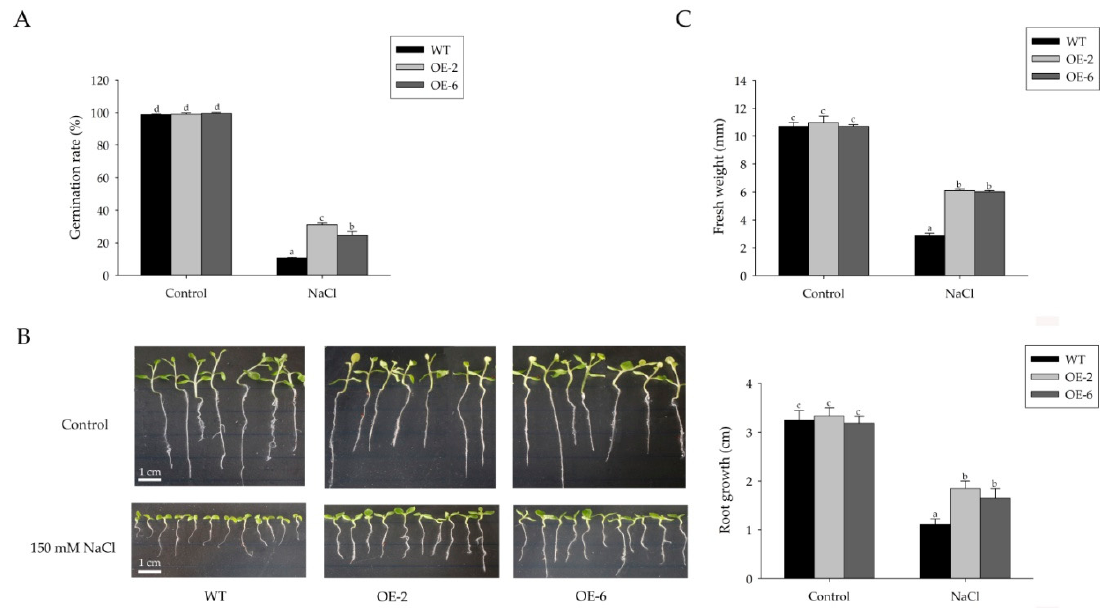
Figure 3. Salt stress tolerance assays of transgenic Nicotiana benthamiana . ( A ) Germination rates of wild type (WT) and miR408-overexpressing tobacco (OE2 and OE6) on MS medium containing 150 mM NaCl for 7 days. ( B , C ) The seedling phenotype ( B ) and statistical analysis of root length and fresh weight ( C ) when the seeds of transgenic lines (OE2 and OE6) and WT tobacco were cultured on MS medium and MS medium containing 150 mM NaCl for 21 days The error bars represent standard deviations of the mean measurements. Significant differences were determined using Duncan’s multiple range test (indicated by different letters at p < 0.05).